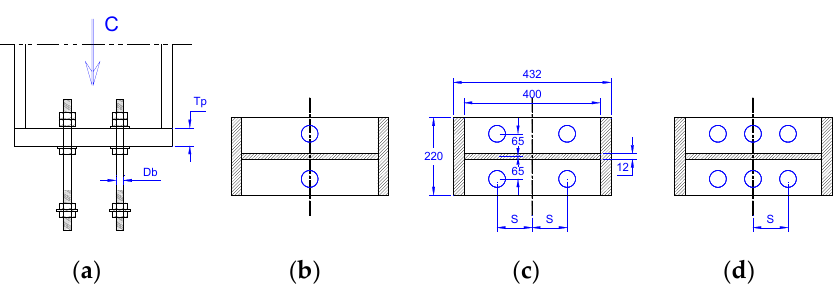
Figure 8. Various arrangements of the base plate connection: ( a ) sectional elevation, ( b ) plan of two anchors, ( c ) plan of four anchors, and ( d ) plan of six anchors.